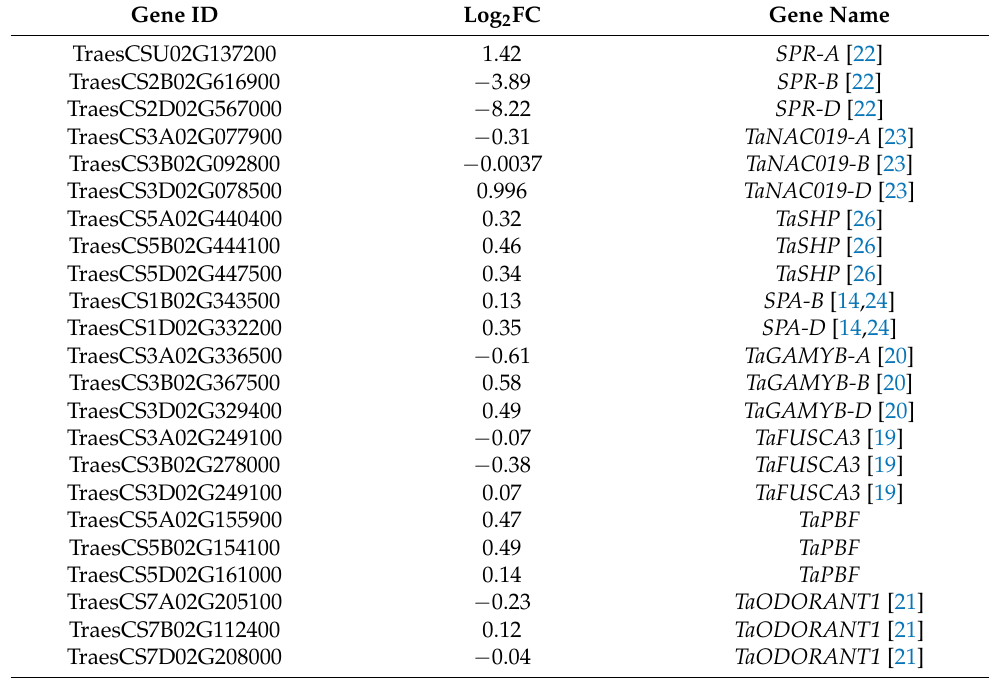
Table 1. Expression of the genes encoding transcription factors that regulate SSP gene expression. Gene ID Log 2